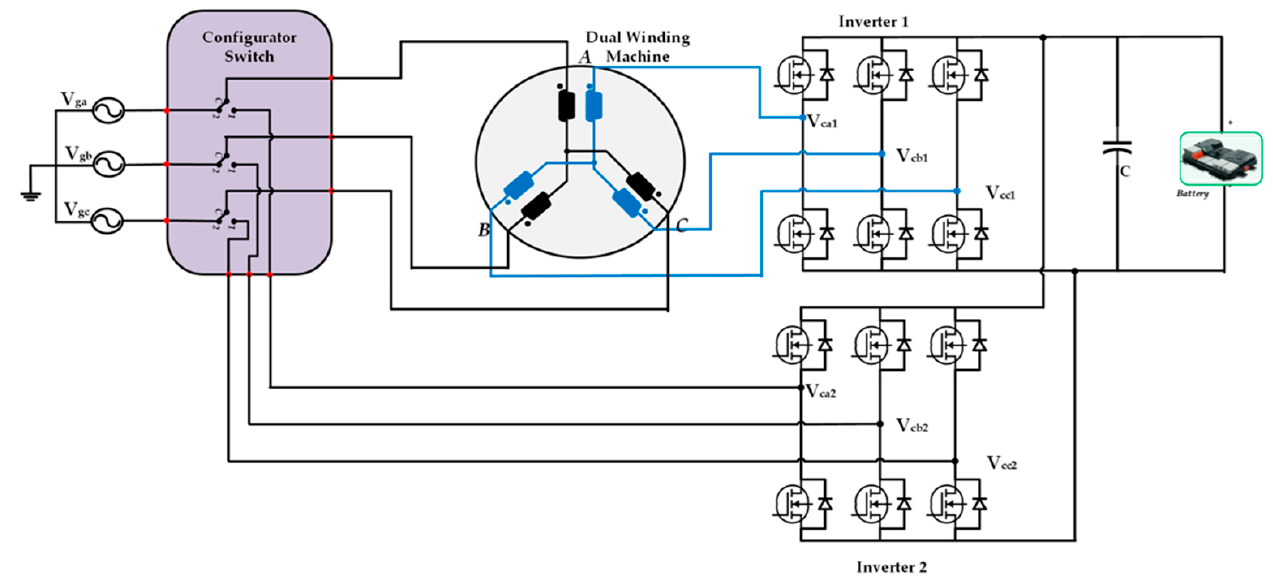
Figure 19. Isolated Integrated On − Board Charger based on Six Phase Machine Reconfiguration proposed by Pascetto et al. [94] in 2020 (iOBC15).